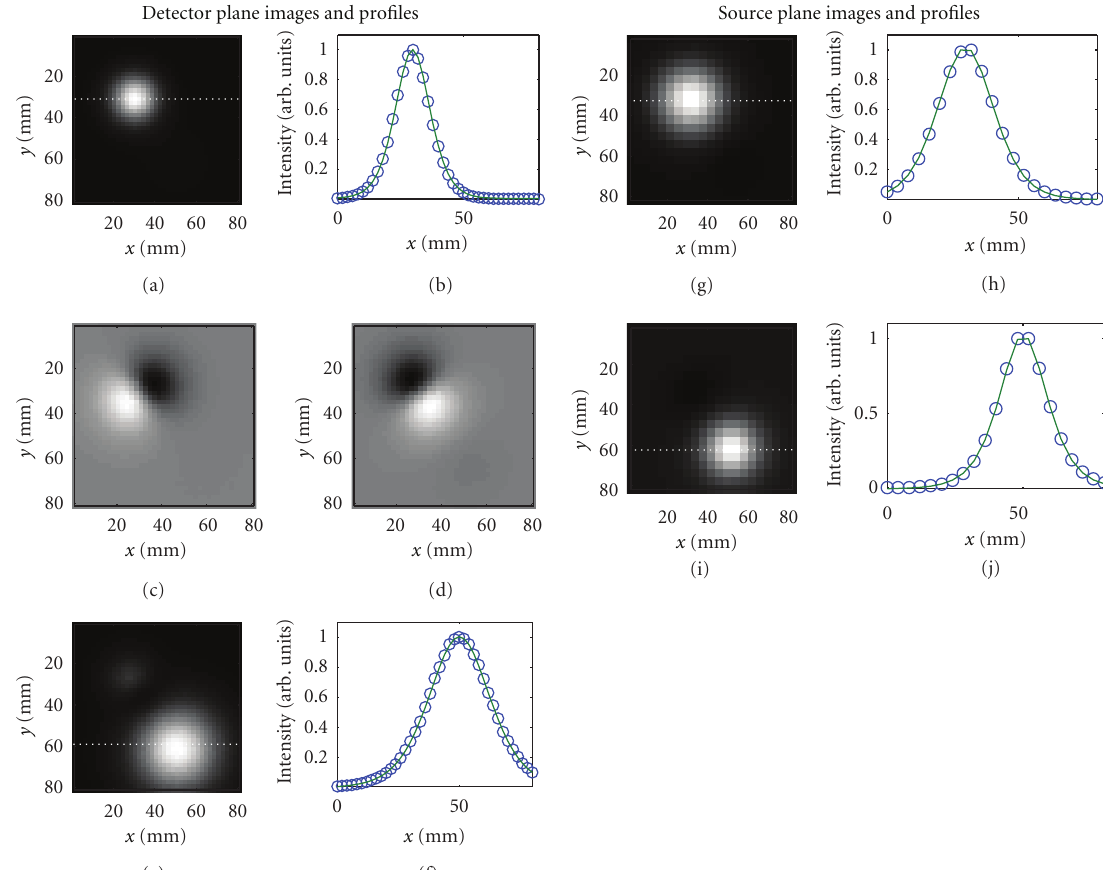
Figure 2: ICA-extracted two-dimensional intensity distribution on the detector plane of: (a) the centrosymmetric component; (c) and (d) dumb-bell shaped components of the scattering target; (e) the absorptive target. Similar intensity distribution on the source plane of: (g) the centrosymmetric component of the scattering target and (i) the absorptive target for comparison. Fits to the spatial intensity profile on the detector plane along the white dashed line (shown in figures) of the centrosymmetric component of the scattering target is shown in (b), and that of the absorptive target is shown in (f). Corresponding fits to spatial profiles on the source plane are displayed in (h) and (j), respectively.